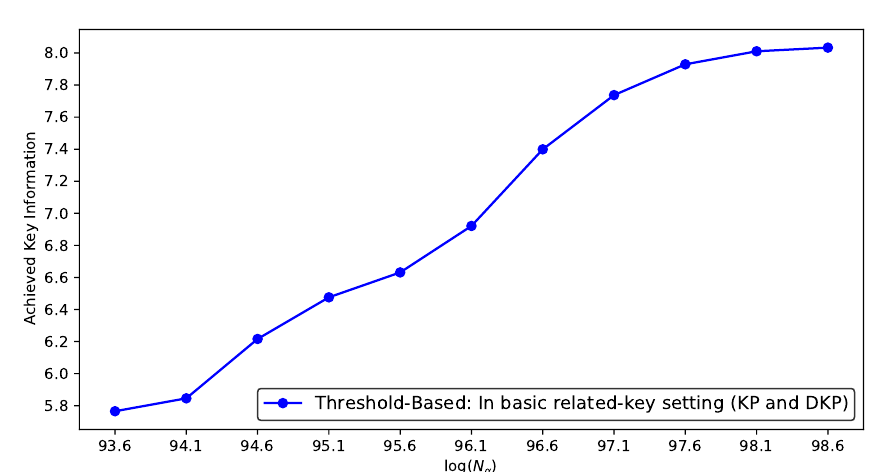
Figure 9: The achieved key information of the basic related-key attacks on TinyJAMBU using the threshold-based model.